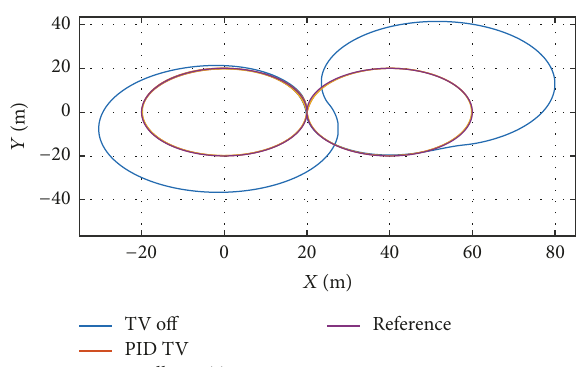
Figure 11: Skid-pad trajectory.